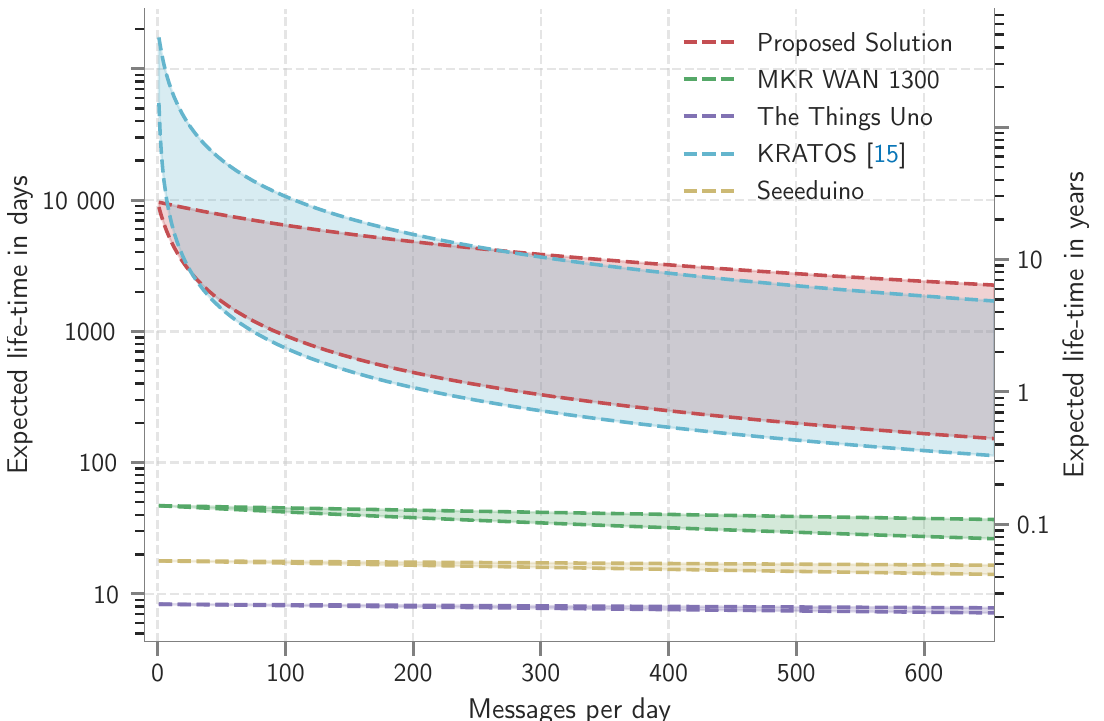
Figure 5. Expected operation time in terms of messages per day for spreading factors 7 (upper-bound)